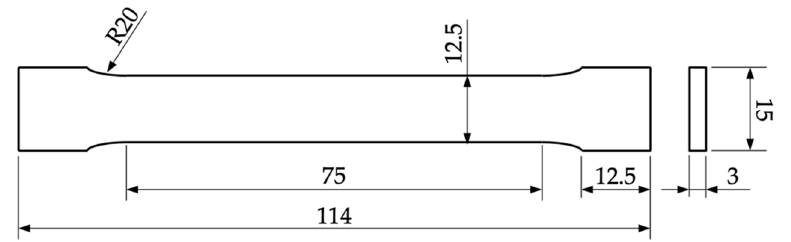
Figure 4. Tensile specimen with a total length of 114 mm and a test length of 75 mm. The specimens were printed horizontally so that the height correlated with the stacking direction.